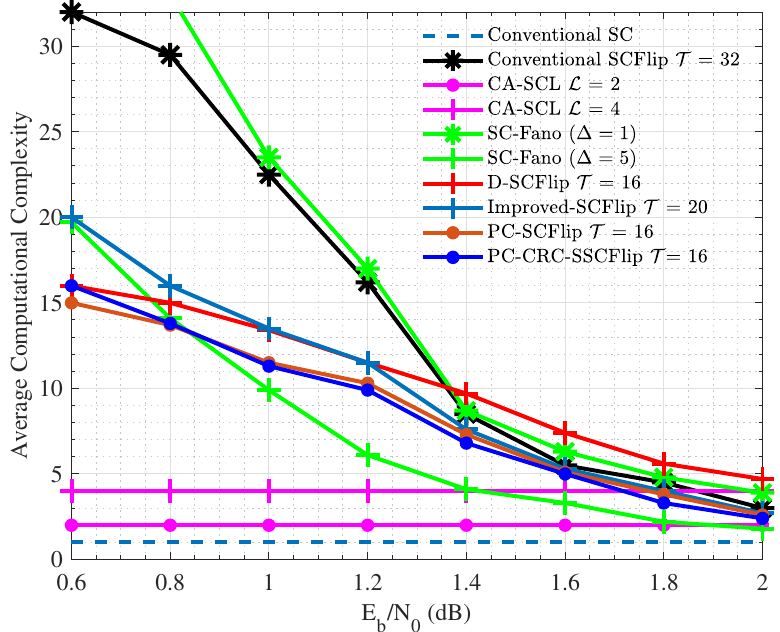
Figure 6. Average computational complexity comparison of the PC-CRC-SSCFlip decoder with different other SC flip decoder for P ( 1024,512 ) with 24 check